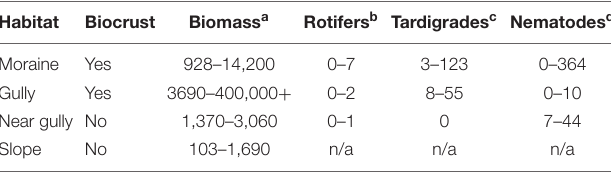
TABLE 2 | Abundance data by